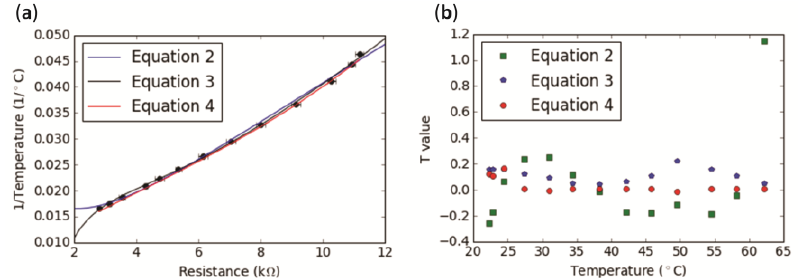
Figure 2. Calibration showing readings from five electronic temperature-sensing yarns (ETS yarns). ( a ) The averaged values of the resistances of the five electronic temperature-sensing yarns have been plotted (black markers) against the reciprocal of the temperature. Two polynomial fittings were applied as well as the manufacturer’s equation to calculate the reciprocal of temperature; ( b ) Residuals for each of the Equations (2)–(4).